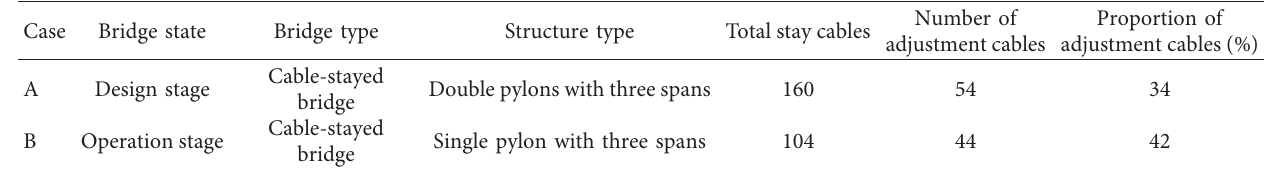
Table 6: Summary of cable adjustment in engineering